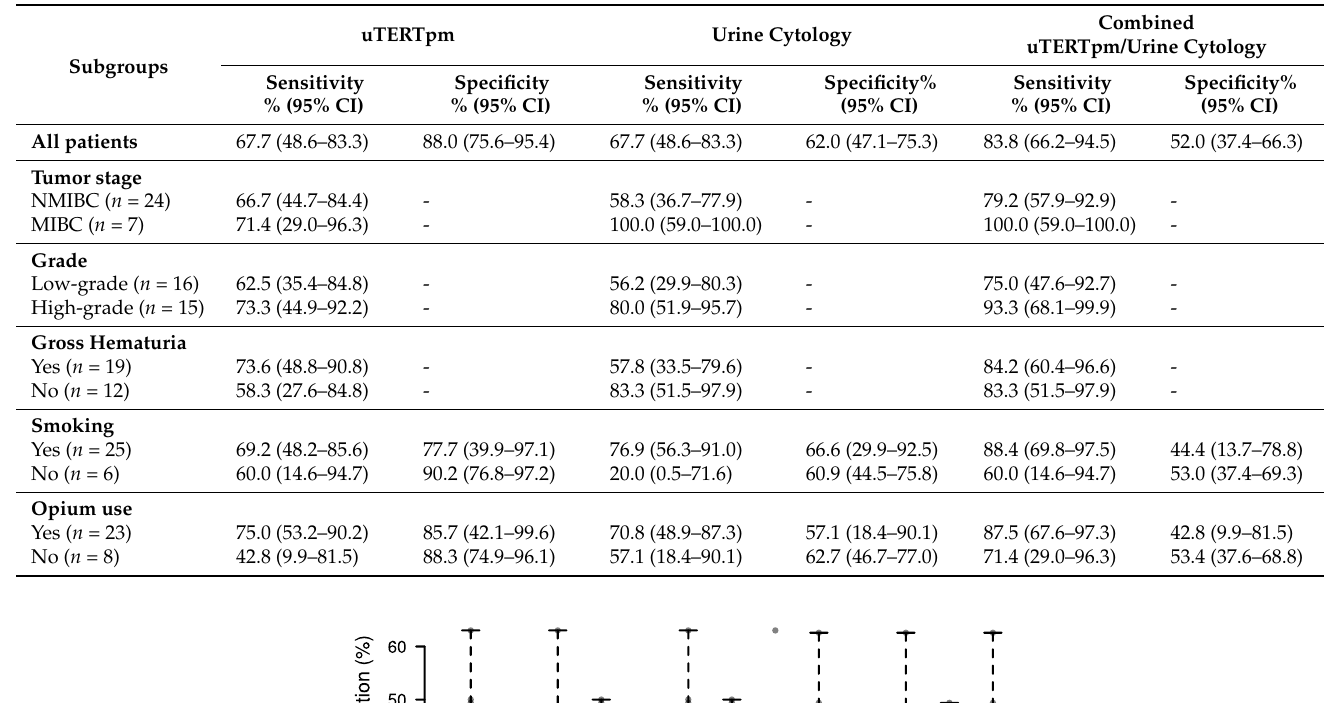
Table 3. Performance of uTERTpm and cytology in detecting primary and recurrent bladder cancers across different subgroups of patients.